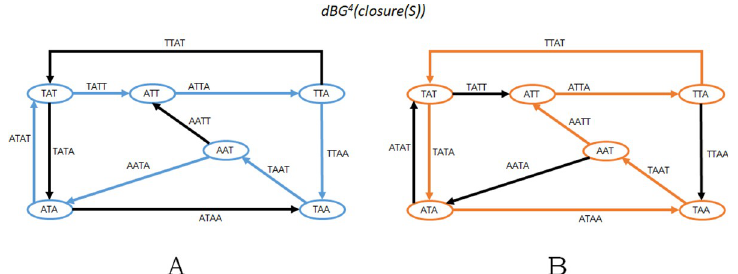
Fig 2. Using the same example as in Fig 1, this figure shows G 2 = dBG k +1 ( closure ( S )) and the 2 possible Hamiltonian cycles in G 2 . Notice that the k -mer sequence corresponding to the blue cycle in Panel A is the same as in Fig 1A; similarly, the k -mer sequence for the orange cycle in Panel B is the same as in Fig 1B.